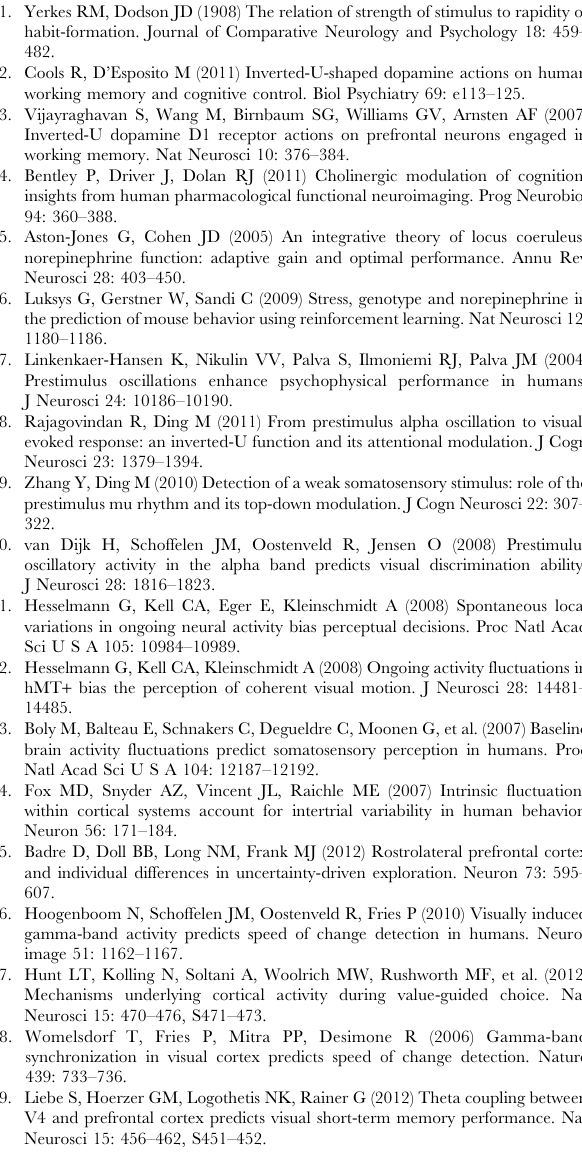
Figure S2 Correlation between RTs and D(t) across subjects. Related to Fig. 4B (top). The first PC was extracted from each subject’s data (using contralateral hand). Its distance-to- mean D(t) time course was computed for each trial and averaged within a post-stimulus 340 , 510 ms window around the behav- ioral response, then plotted against RT across all hit trials in all subjects. Different colors indicate different subjects. The Pearson correlation coefficient and associated P-value computed across all subjects are indicated in the graph. Table S1 Talairach coordinates (mm) of electrodes showing a significant linear or quadratic relationship